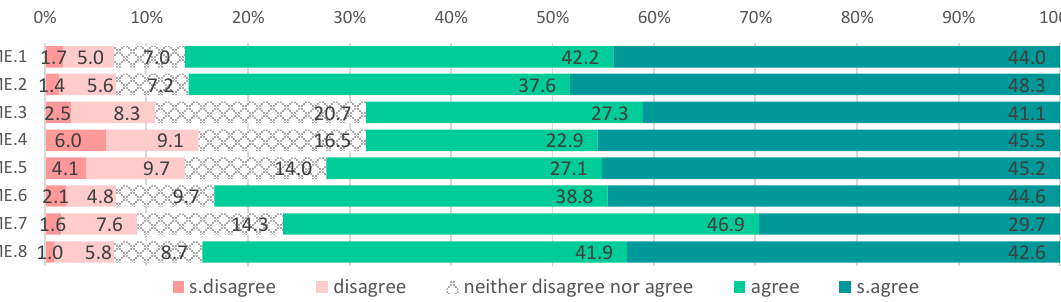
Figure 5. The merit of IGS. (ME.1) IGS makes urban landscape beautiful; (ME.2) IGS can make me feel nature in an urban area; (ME.3) IGS is easy to access because it is close to where I live; (ME.4) it is possible to use IGS freely in many ways; (ME.5) IGS can be a place where children can play; (ME.6) IGS can be a habitat for living things; (ME.7) IGS has the effect of suppressing dust; and (ME.8) IGS can be useful for air purification.